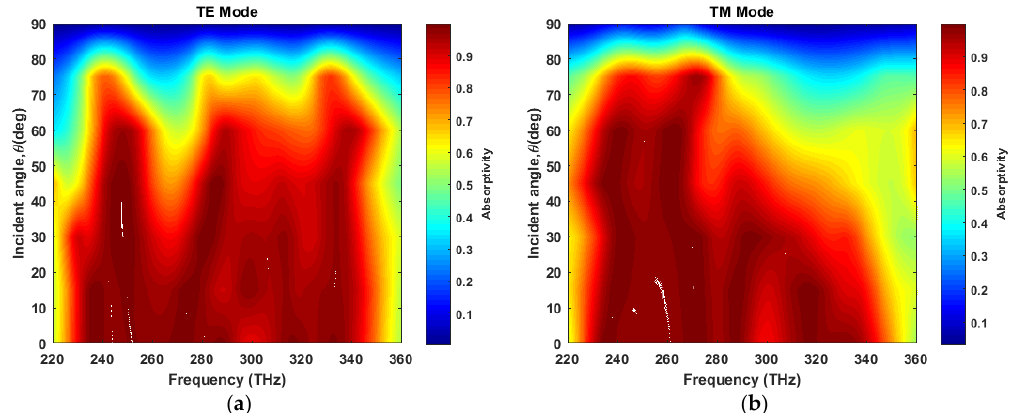
Figure 6. Angular sensitivity to varying incident angle, θ at ( a ) TE mode and ( b ) TM mode.